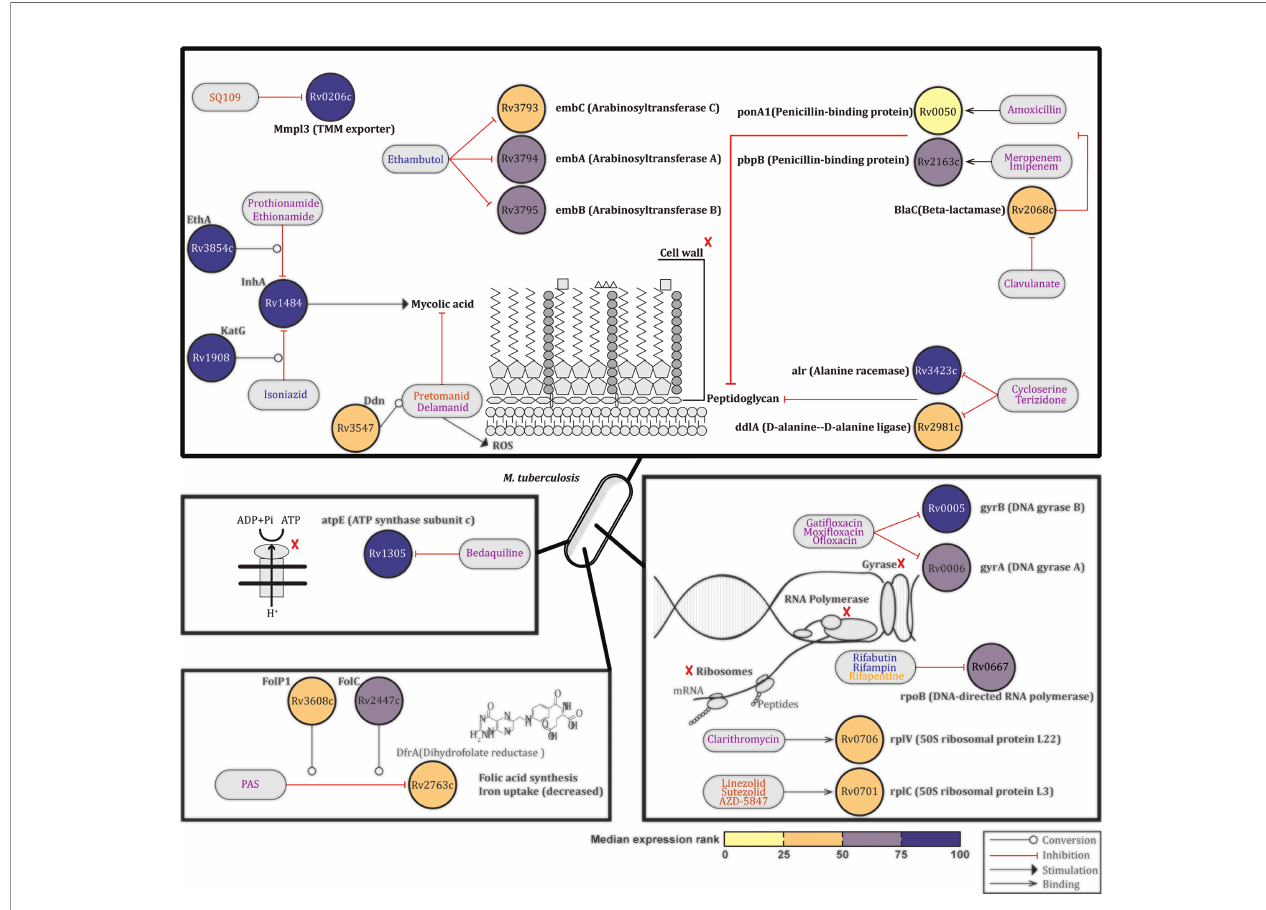
FIGURE 4 | Expression pro fi les of Mtb genes encoding TB drugs targets. Based on the information available on the TBDRUGS - Database of Drugs for Tuberculosis (version 1.0), available at http://bmi.icmr.org.in/tbdrugs/, the median expression ranks of 22 Mtb genes encoding TB drugs targets or prodrug-drug converting enzyme were evaluated across published (8, 10, 11, 14) lung Mtb infection-centred transcriptomic datasets. Nodes representing genes are colored based on the median expression rank. Blue, magenta and orange text indicate fi rst-line drugs, other approved drugs or drugs evaluated in clinical trials, respectively. Source data are provided in Supplementary Table 1